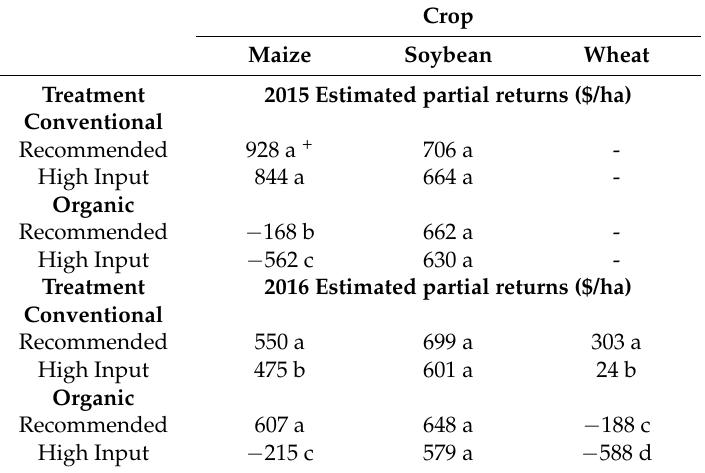
Table 7. Estimated partial returns of maize, soybean and wheat in conventional and organic cropping systems with recommended and high input management in 2015 (maize and soybean) and 2016 (all three crops) in central